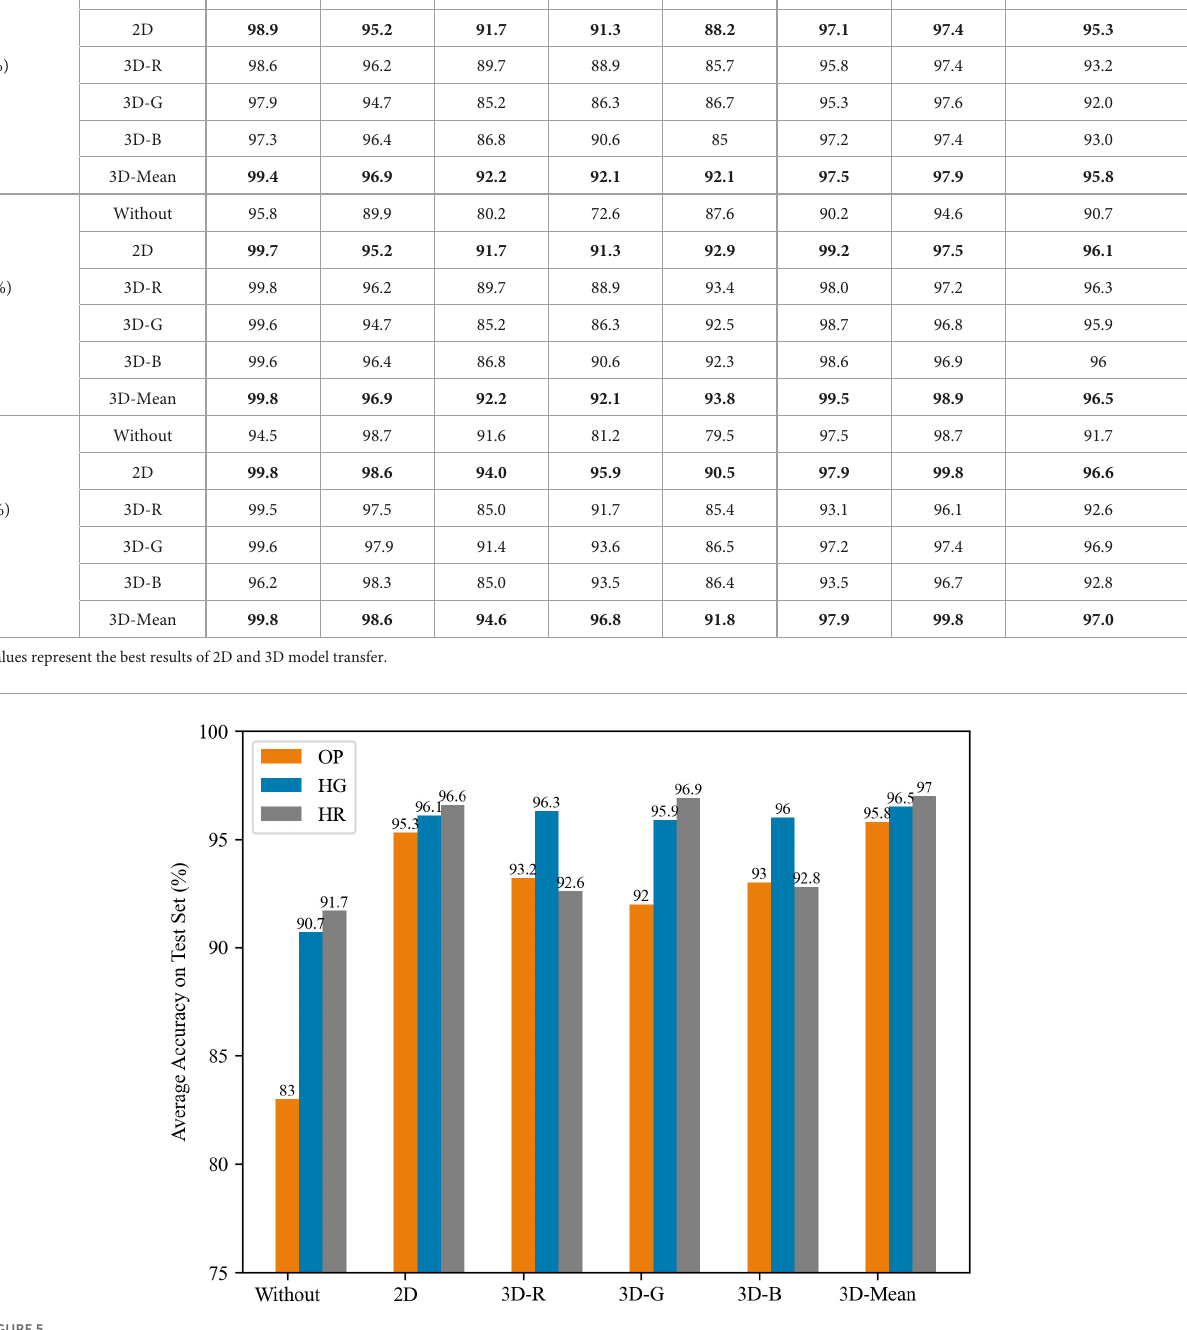
FIGURE5 The average results of different transfer way by OP, HG, and HR models.